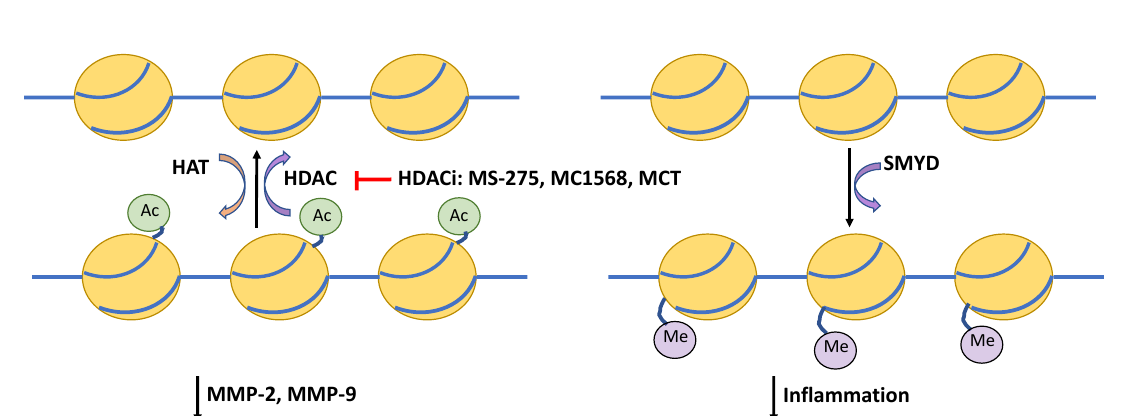
Figure 2. Schematic depicting regulators of histone acetylation and DNA methylation in AAA. Histone deacetylases (HDAC) and histone acetylase transferases (HAT) provide post-transcriptional modification via removing or attaching an acetyl group at the lysine residue. HDAC inhibitors (HDACi) MS-275, MC1568, and metacept (MCT) inhibit acetylation, which has been shown to reduce levels of matrix metallopeptidases (MMP)-2 and-9, and in turn protect the extracellular matrix from degradation. The SET and MYND domain-containing (SMYD) promoter region is hypomethylated in AAA compared to controls. SMYD itself is able to methylation of promoters of interleukin-6 (IL-6), tumor necrosis factor α (TNF α ), and hypoxia inducible factor 1 α (HIF1 α ) and suppress inflammatory